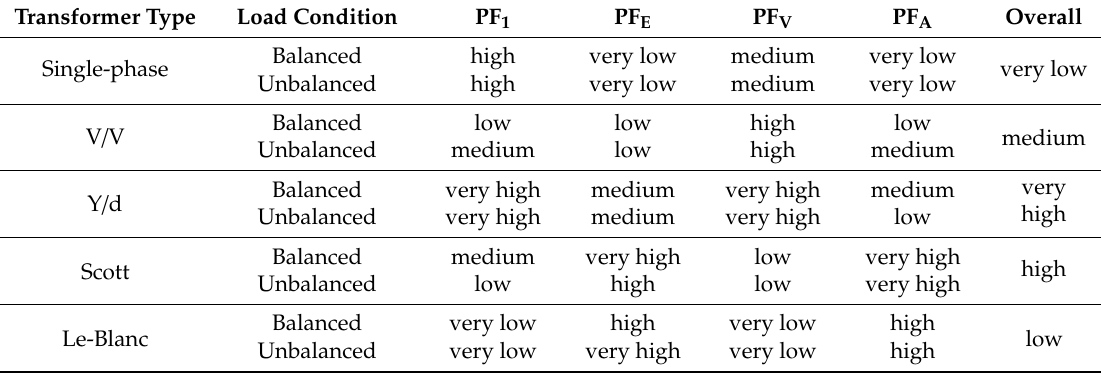
Table 2. Performance of di ff erent traction transformers based on PF definitions in the harmonic presence. Transformer